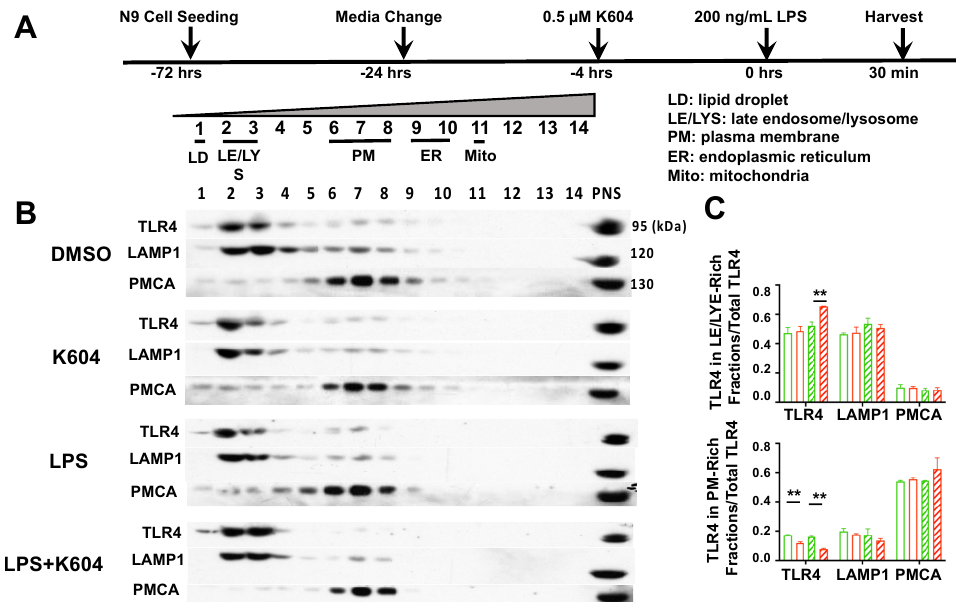
separate fractions: LE/LYS (fractions 2–3) and PM (fractions 6–8), with the contents in the LE/LYS fraction dominating over those in the PM fraction.